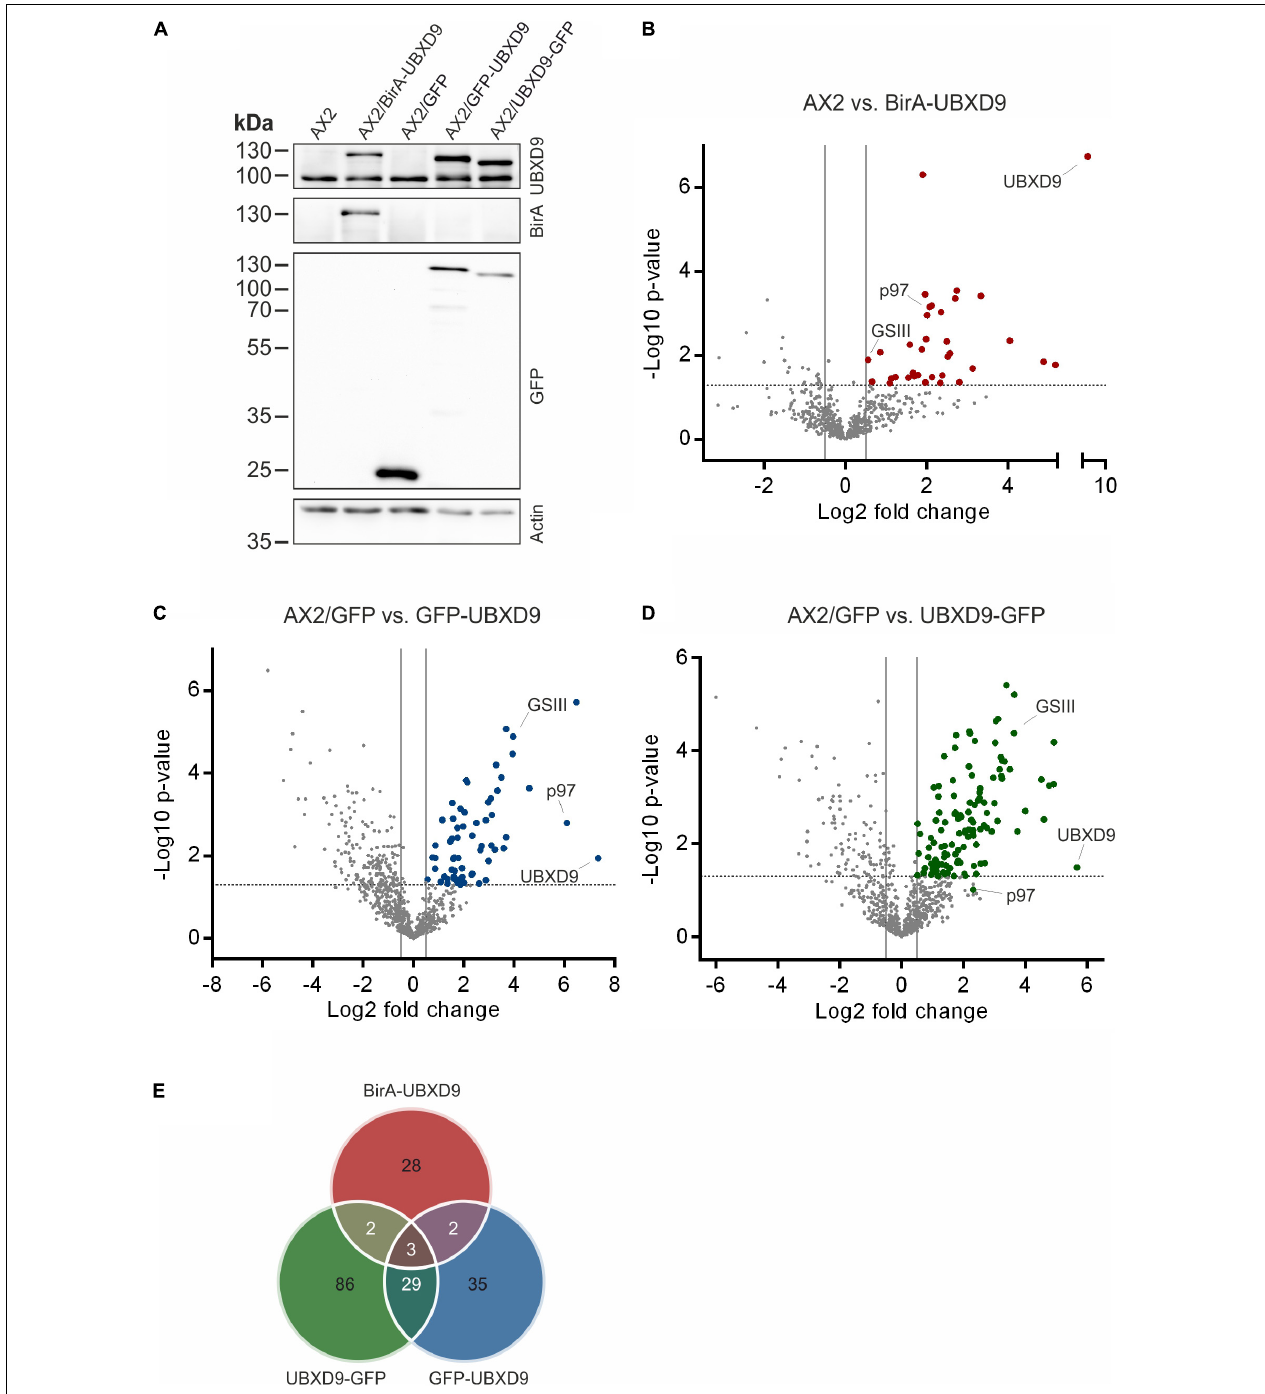
FIGURE 6 | Interaction proteomics. (A) Verification of the BirA-UBXD9, GFP, GFP-UBXD9, and UBXD9-GFP expressing strains by western blotting using the polyclonal UBXD9 (top panel), the polyclonal BirA (2nd panel from top), and the monoclonal GFP (3rd panel from top) antibodies. Detection of actin (bottom panel) with the monoclonal actin antibody was used as loading control. (B–D) Volcano plots depicting p -value versus fold change (FC) for all proteins identified by mass spectrometry in AX2 versus AX2/BirA-UBXD9 expressing cells (B) , AX2/GFP versus AX2/GFP-UBXD9 expressing cells (C) and AX2/GFP versus AX2/UBXD9-GFP expressing cells (D) . Putative UBXD9 interacting proteins with a fold change ≥ 1.4 and a p ≤ 0.05 are depicted as red, blue or green dots, respectively. Dots representing UBXD9, p97, and glutamine synthetase type III (GSIII) are indicated. The plots were done using GraphPad prism. (E) Venn diagram of significantly enriched proteins in the pull-down experiments of AX2/BirA-UBXD9 (red), AX2/GFP-UBXD9 (blue), and AX2/UBXD9-GFP (green) cells. The intersections of the circles provide the number of proteins that were identified in two or all three approaches. Only those proteins with a fold change ≥ 1.4 and a p ≤ 0.05 were used as input.